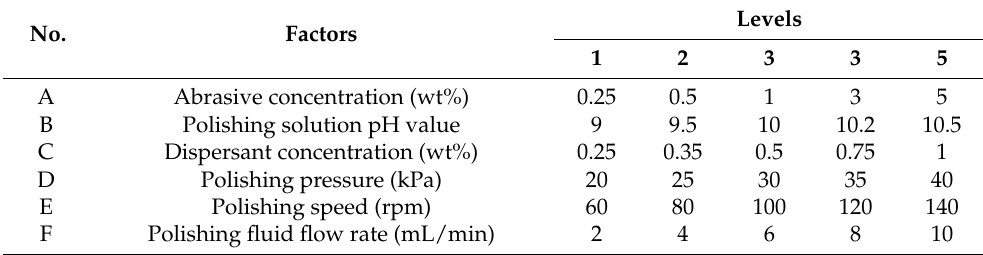
Table 1. L5 6 orthogonal experiment factor level